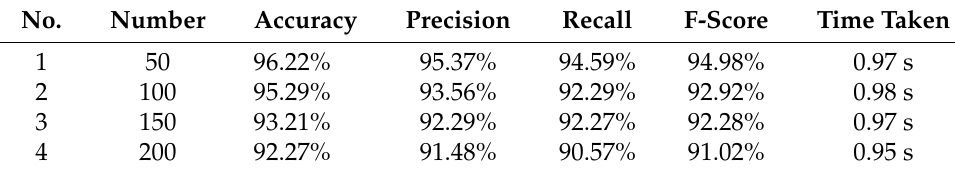
Table 4. Command type b Experimental